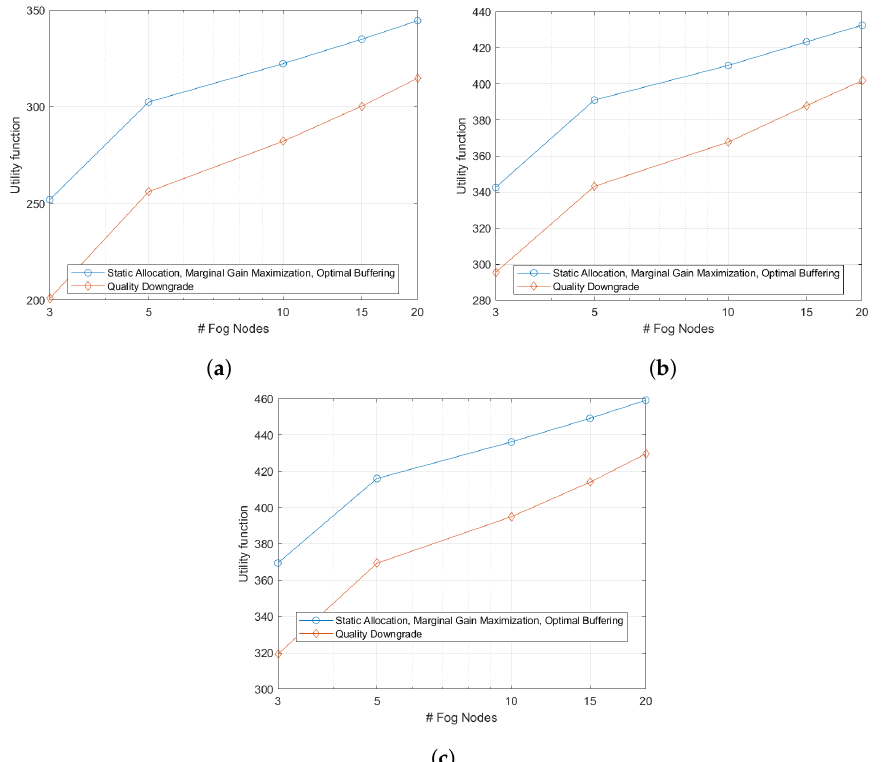
Figure 7. Utility function with variable number of nodes. ( a ) Short videos. ( b ) Medium videos. ( c ) Long